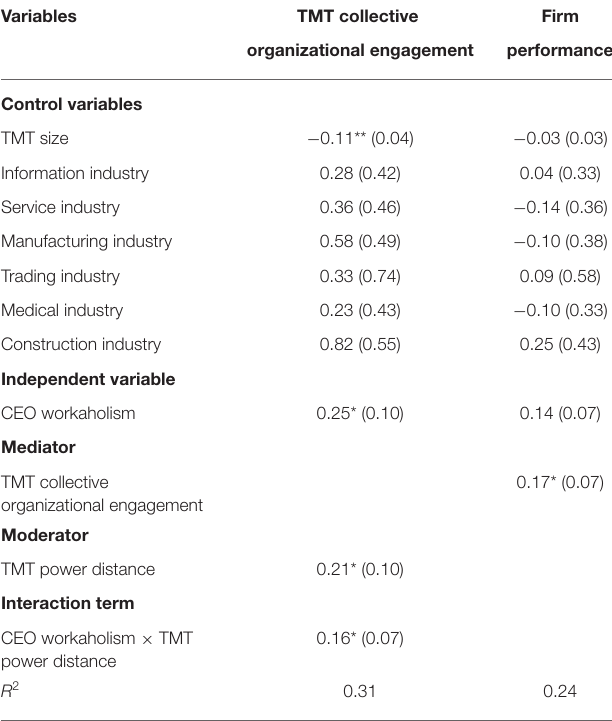
TABLE 3 | Path analysis results.